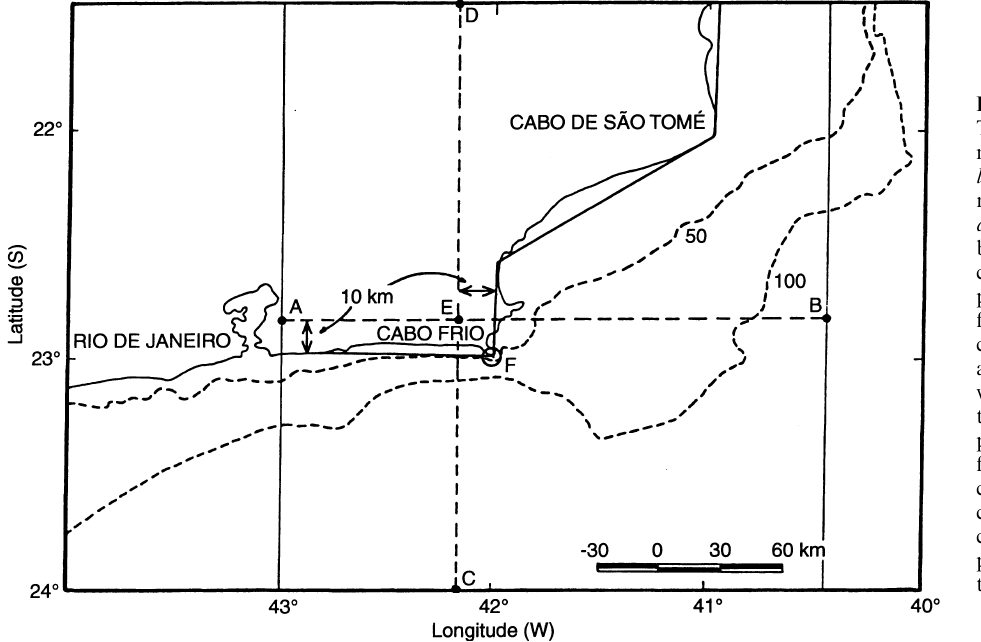
Fig. 1. Region of Cabo Frio. The coastline considered in the model is indicated by a thick line. The smaller rectangle rep- resents the model domain. The dashed lines represent the iso- baths in m. The line AB indi- cates grid-points along a parallel line 10 km northward from the EW coast; the line CD corresponds to grid-points along a parallel line 10 km westward from the NS coast; the point E represents a grid- point situated 10 km inland from both the EW and NS coastlines; F indicates the inter- ception of the EW and NS coastlines. These lines and points are useful for analyzing